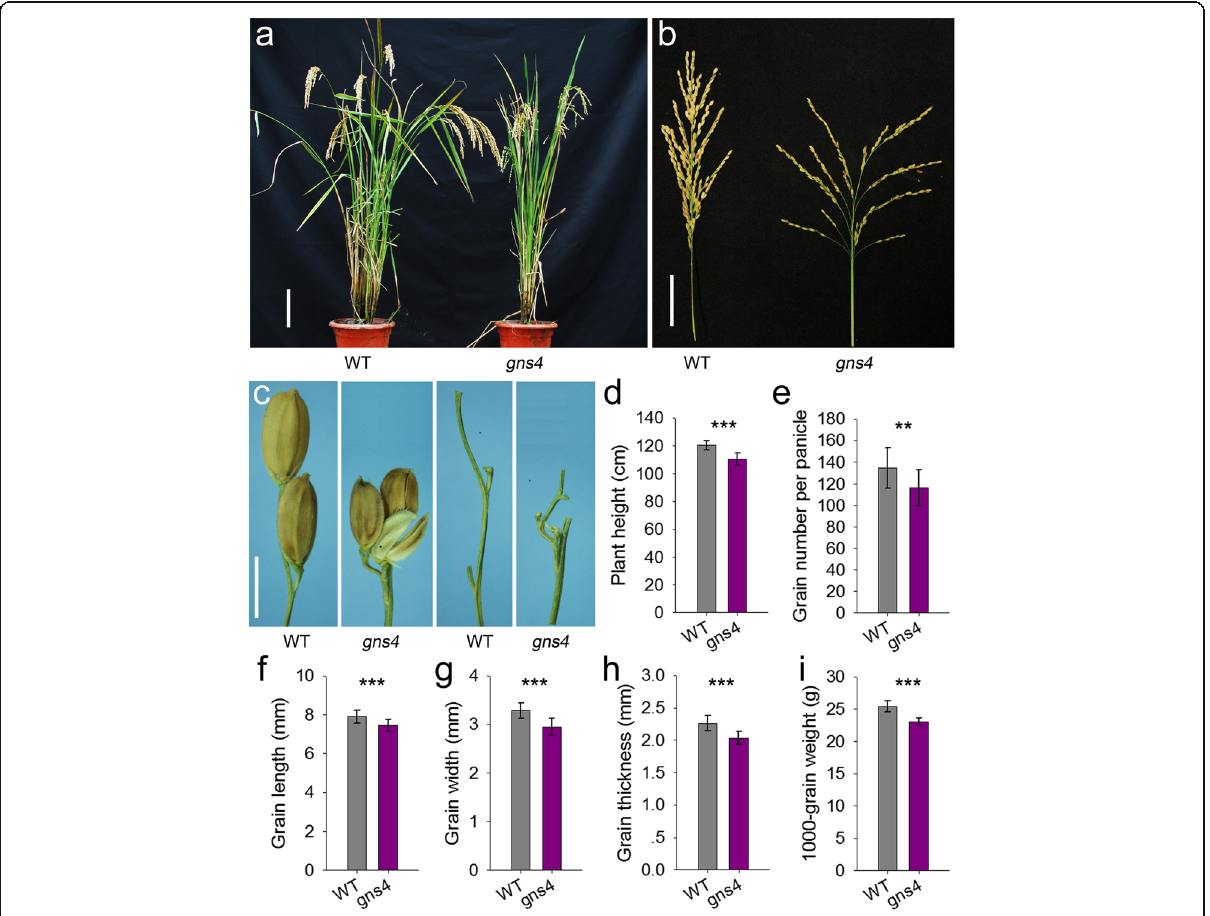
Fig. 1 Morphological characteristics of the gns4 mutant. a Gross morphologies of WT and gns4 mutant at mature stage. Scale bar, 15 cm. b Panicle phenotypes of WT and gns4 mutant. Scale bar, 5 cm. c Grains and pedicels of WT and gns4 mutant. Scale bar, 5 mm. d-i Comparison of agronomic traits between WT and gns4 mutant. Data are given as means ± s.e. ( n ≥ 20). Significant at ***0.1% and